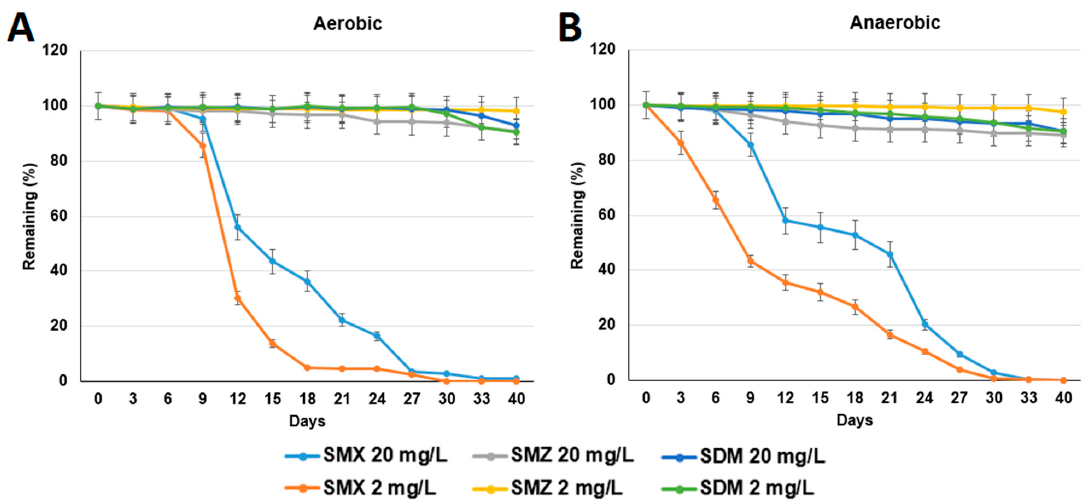
Figure 1. Biodegradation of three sulfonamides in milkfish ( Chanos chanos ) pond sediments under aerobic ( A ) and anaerobic ( B ) conditions. SMX: sulfamethoxazole, SDM: sulfadimethoxine, SMZ: sulfamethazine. Data from three independent experiments are presented as the mean ± SE.